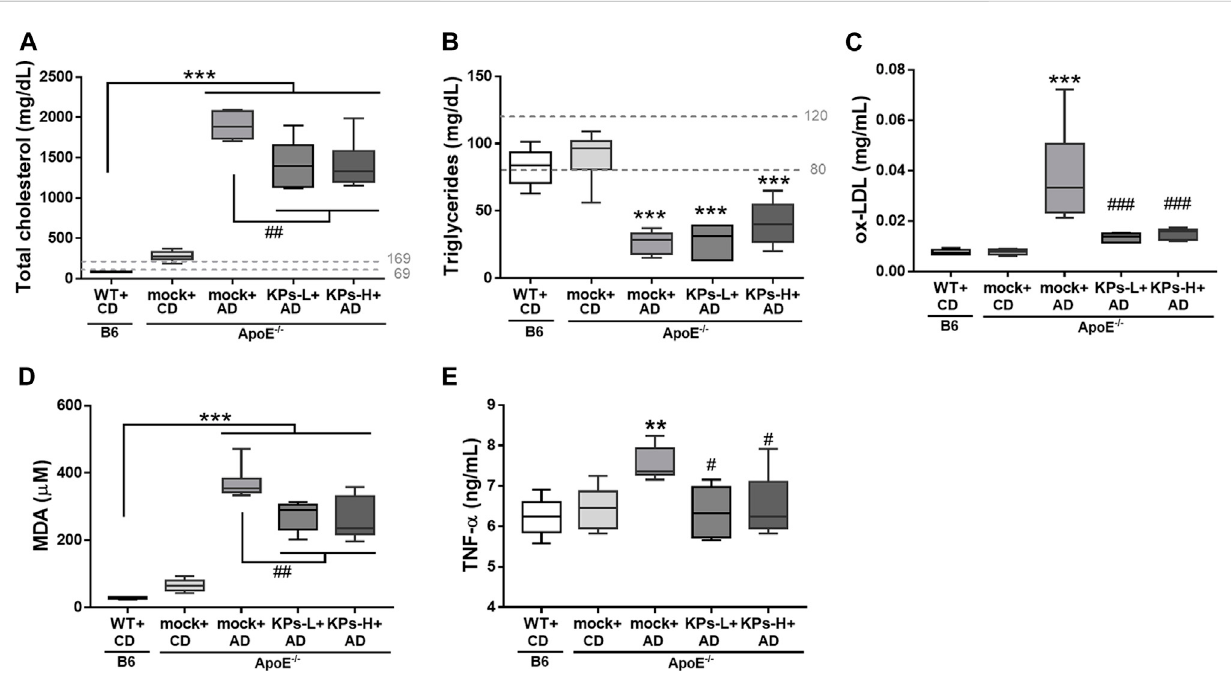
FIGURE 1 Effects ofKPson serum (A) cholesterol, (B) triglyceride, (C) ox-LDL, (D) MDA, (E) TNF- α . Thedashedlinesindicate thenormalranges oftarget serum markersinmice.Statisticalsigns( n =6):* p < 0.05,** p < 0.01,*** p < 0.001vs.WT+CD/B6,and # p < 0.05, ## p < 0.01, ### p < 0.001vs.mock+AD/ ApoE − / − .